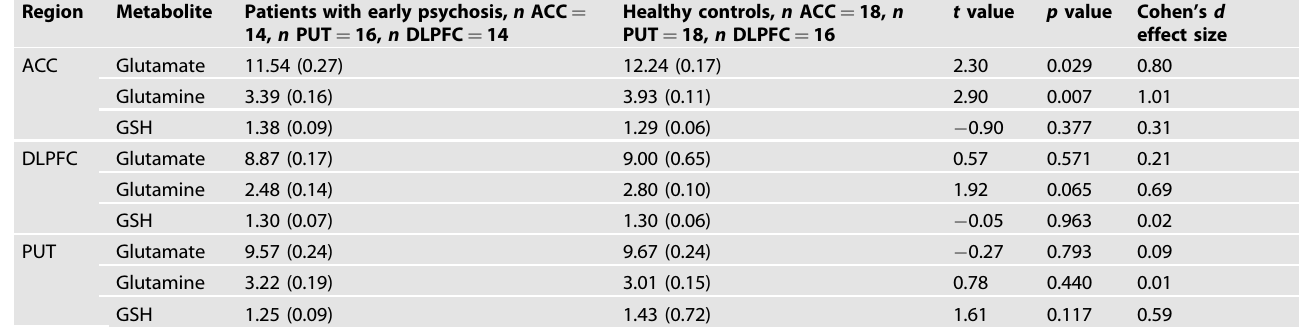
Table 2. Mean (SEM) absolute concentrations ( μ mol/g) of glutamate, glutamine and GSH, corrected for GM, WM and CSF content in ACC, DLPFC and PUT.